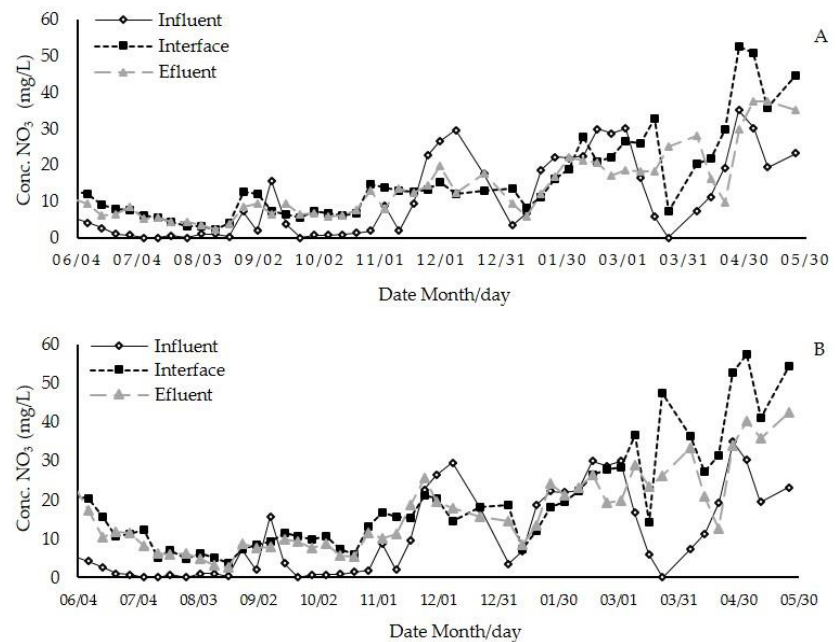
Figure 11. Measurements of nitrate at three points in system I (SI) ( A ) and system II (SII) ( B ) during the